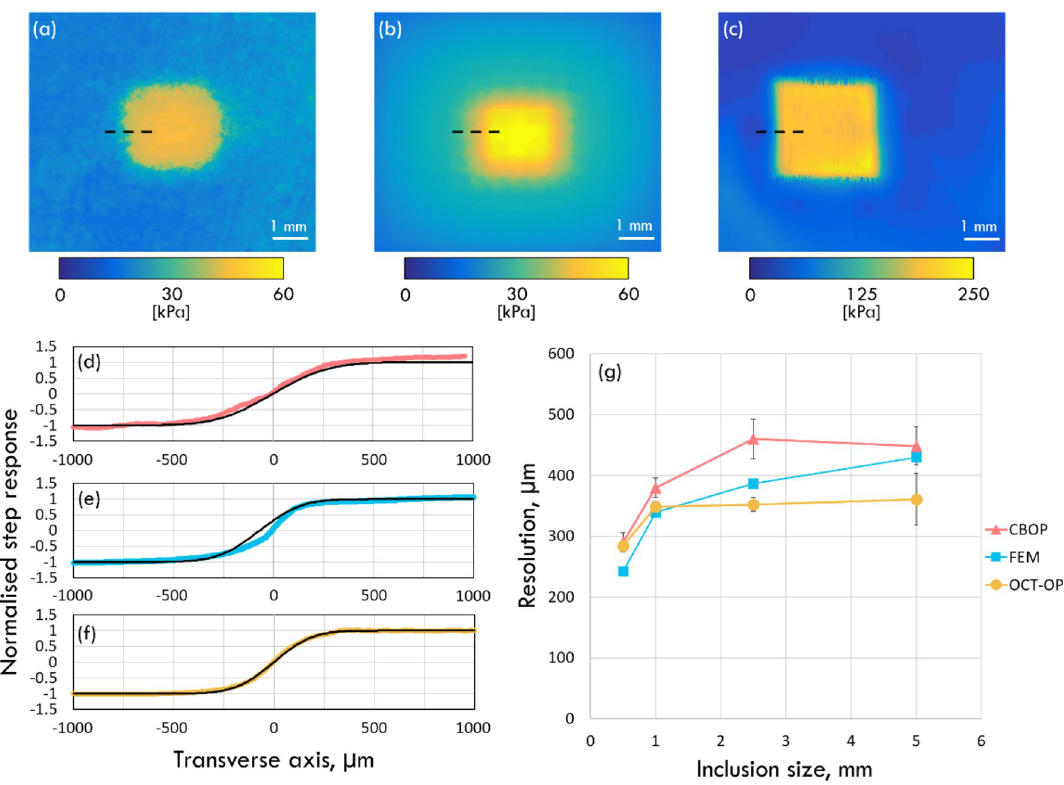
Figure 5. Analysis of the lateral resolutions of CBOP and OCT-based optical palpation. Optical palpograms acquired using ( a ) CBOP at 50% bulk preloaded strain, ( b ) FEM of CBOP and ( c ) OCT-based optical palpation at 50% bulk preloaded strain on a 2.5 × 2.5 × 1 mm inclusion embedded within a soft phantom. The normalised step response (coloured points) and error function (black line) of ( d ) CBOP, ( e ) FEM and ( f ) OCT-based optical palpation are taken across the boundary of the same inclusion phantom. ( g ) The lateral resolution measured using CBOP, OCT-based optical palpation and FEA, across five locations on each inclusion phantom with error bars representing one standard